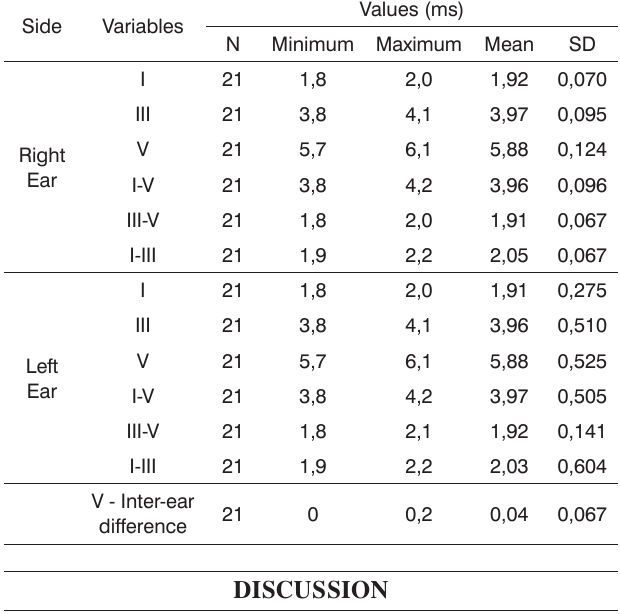
Table 2. Distribution of minimum, maximum, and mean values, and the standard deviation, for brainstem auditory evoked potentials per